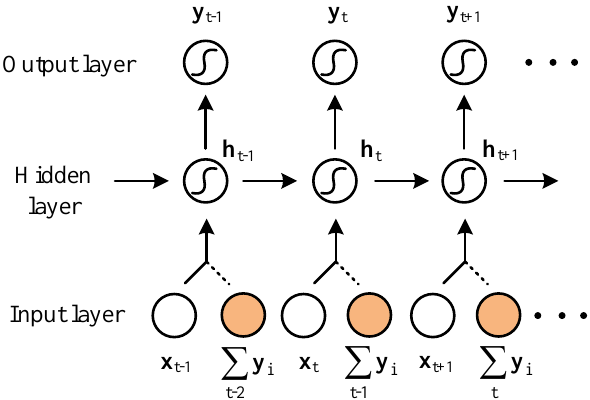
Figure 4. The structure of RRNN unfolded by time.